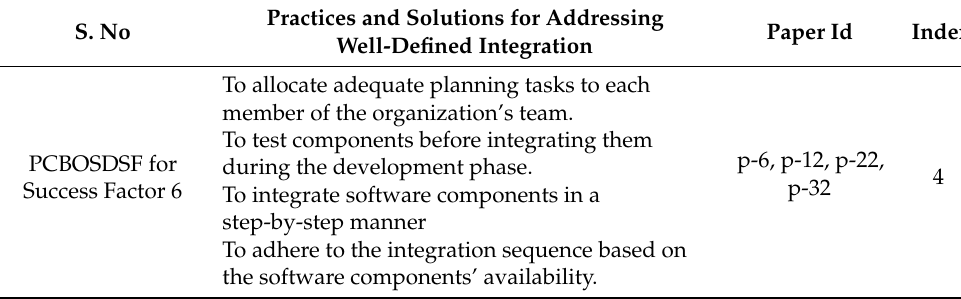
Table 10. CBOSDSF 6: Well-defined integration.